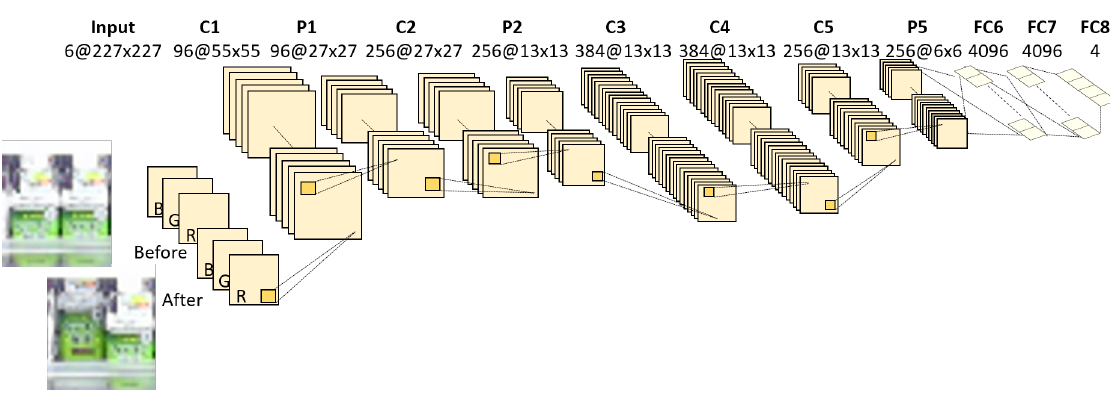
Figure 5. Network architecture based on CaffeNet. It consists of five convolutional layers, three pooling layers and three fully-connected layers.